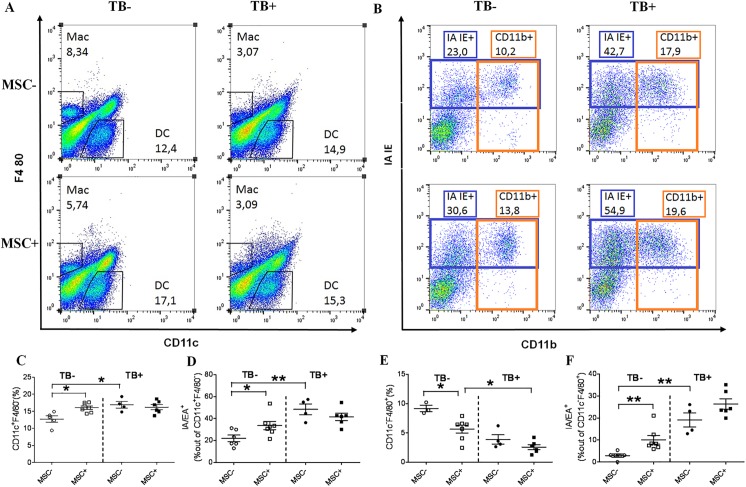
MSC promote the accumulation of DC and the activation of DC and macrophages in the lungs of uninfected mice.Uninfected mice and mice challenged with Mtb (600 CFU/mouse given aerogenically) were transferred with MSC as described in the legend to Fig 2 and lung cell suspensions were analyzed by flow cytometry. A, Identification of CD11c+F4/80- (DC) and CD11c-F4/80+ (macrophages) populations by flow cytometry. B, Representative example showing the expression of IA/IE and CD11b by lung DC. C, E, Summarized data showing percentages of DC (C) and macrophages (E). D, F, Summarized data showing the expression of MHC class II by DC (D) and macrophages (F).